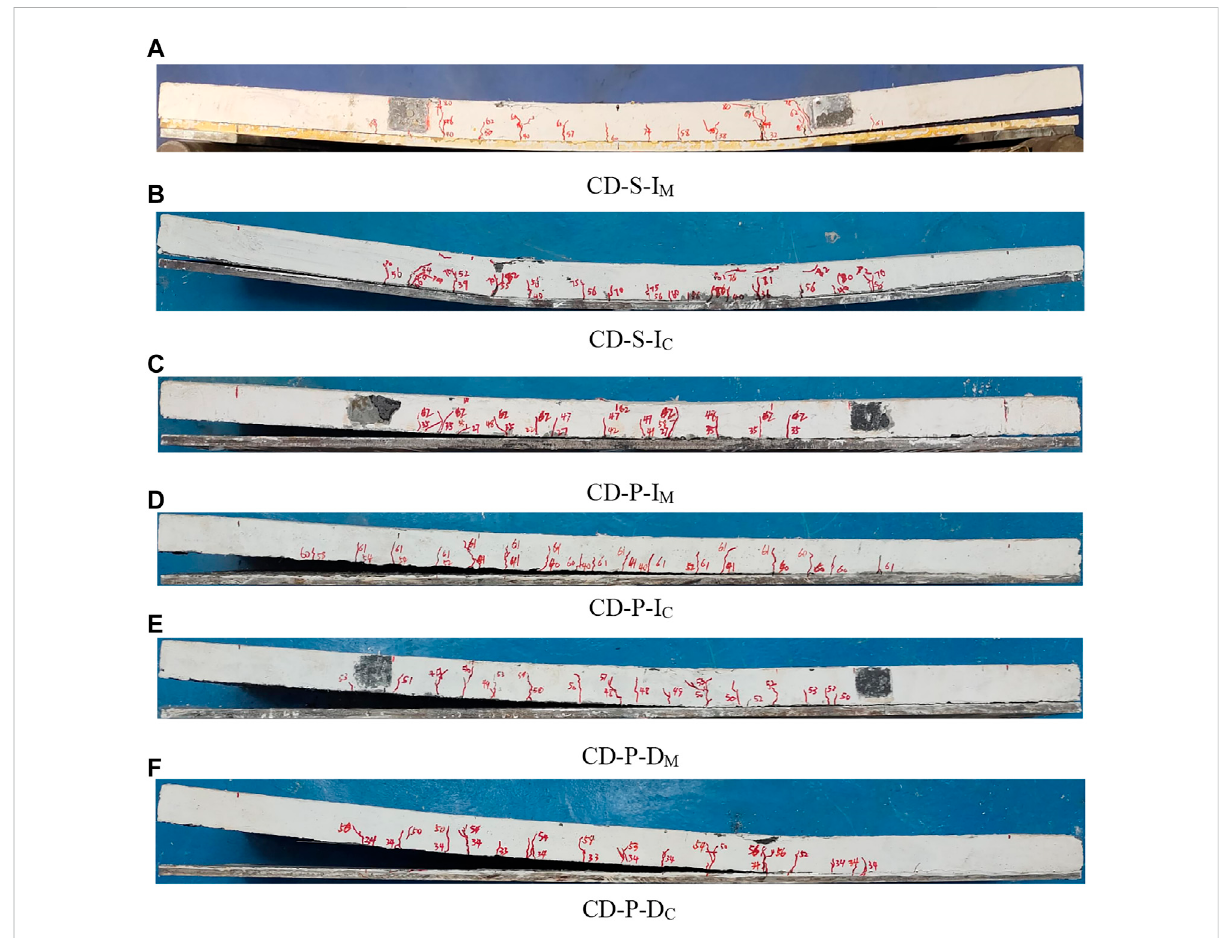
FIGURE 7 Failure of the steel-UHPC composite bridge deck. (A) Specimen CD-S-I M . (B) CD-S-I C . (C) CD-P-I M . (D) CD-P-I C . (E) CD-P-D M . (F) CD-P-D C